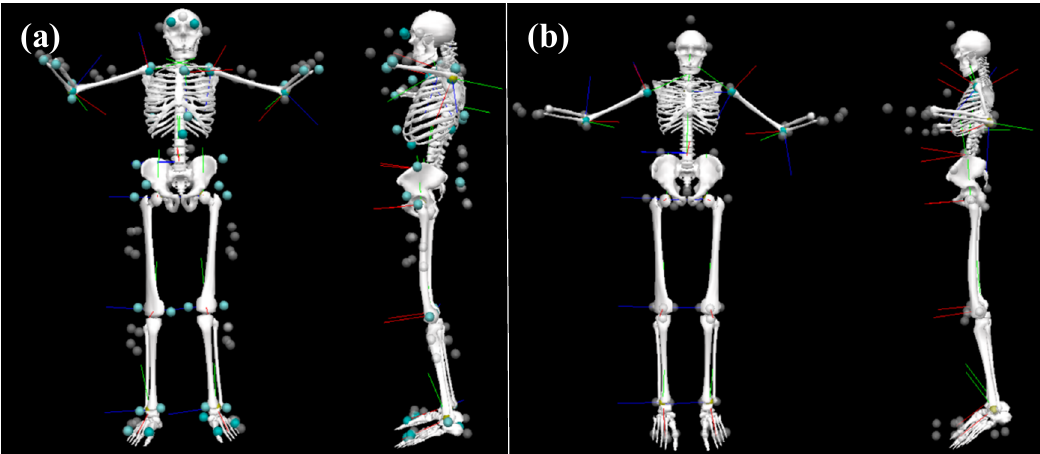
Figure 2. Example Visual3D model for a representative participant. Visual3D’s 6 degree-of-freedom model was used for all joint angle calculations. ( a ) Model built from OPT data (V OPT ). ( b ) Model built with IMU data (V IMU ). Tracking markers used can be found in Supplementary Material Table S2.